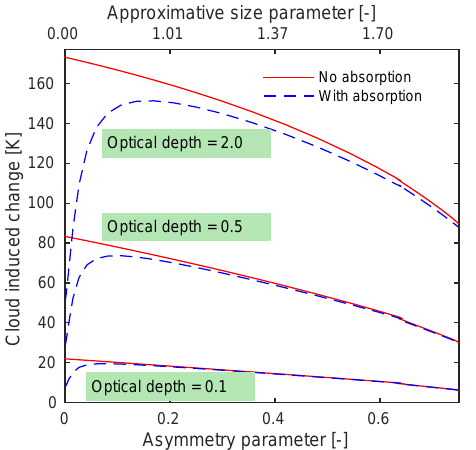
Figure 5. Test of importance of absorption and asymmetry param- eter for passive microwave radiative transfer. The brightness tem- perature deviation from simulations with no cloud layer is reported, where a positive value in the figure corresponds to a decrease in ab- solute brightness temperature. The stated optical depths refer to the zenith extinction of the cloud layer. For solid lines, the imaginary part of the refractive index was set to 0, resulting in no cloud particle absorption. The simulations are described further in the